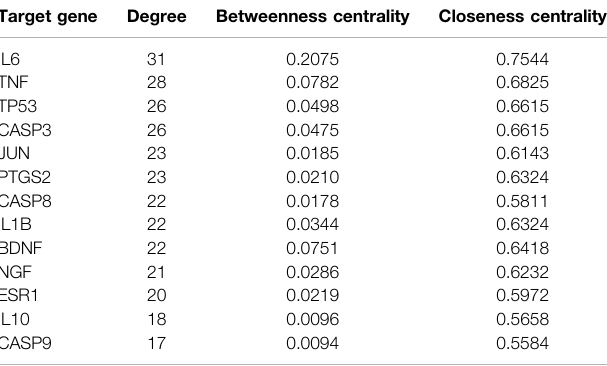
TABLE 4 | Characterization parameters of hub genes. Target